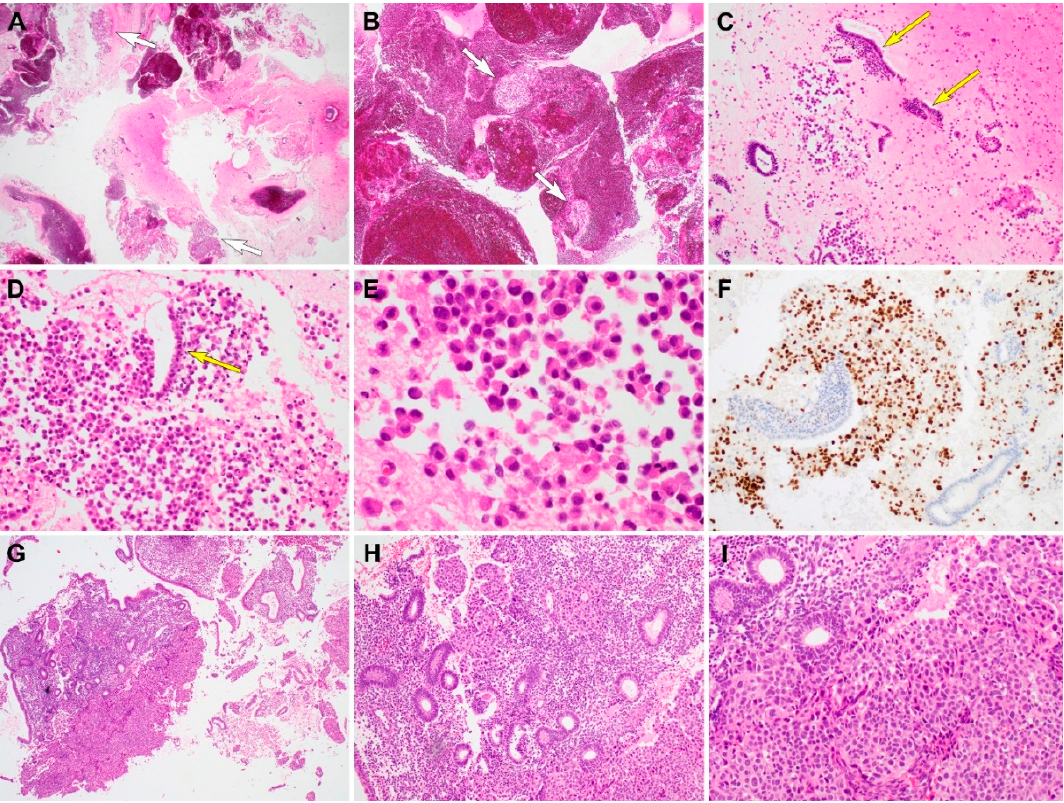
Figure 2. Histopathological findings and immunostaining results of metastatic invasive lobular (case 2) and ductal (case 3) carcinoma. ( A , B ) On scanning view, the curetted specimen consists mainly of blood and fibrin, and a small amount of scattered tissue fragments (short white arrows). ( C ) Low-power magnification shows individual tumor cells and endometrial strips (long yellow arrows) dispersed in the background of a fibrinous exudate. ( D ) Medium-power magnification demonstrates a monotonous population of discohesive tumor cells. A long yellow arrow indicates the endometrial strip located between the tumor cells. ( E ) On high-power magnification, the tumor cells appear round to polygonal and possess eccentrically placed hyperchromatic nuclei and eosinophilic cytoplasm, morphologically compatible with invasive lobular carcinoma of the breast. ( F ) Tumor nuclei are strongly positive for GATA3, whereas the endometrial strips do not express GATA3. ( G ) Metastatic carcinoma cells infiltrating the endometrial stroma. ( H ) Presence of benign endometrial glands, which are entrapped within tumor cells clusters, favors the diagnosis of a metastatic lesion. ( I ) Cohesive tumor cells forming solid sheets and a few small glands, demonstrating morphological compatibility with invasive ductal carcinoma of the breast. They possess large pleomorphic nuclei and abundant eosinophilic cytoplasm. Original magnification: A and B : × 12.5; C : × 40; D : × 40; E : × 200; F : × 40; G : × 12.5; H : × 40, I : ×